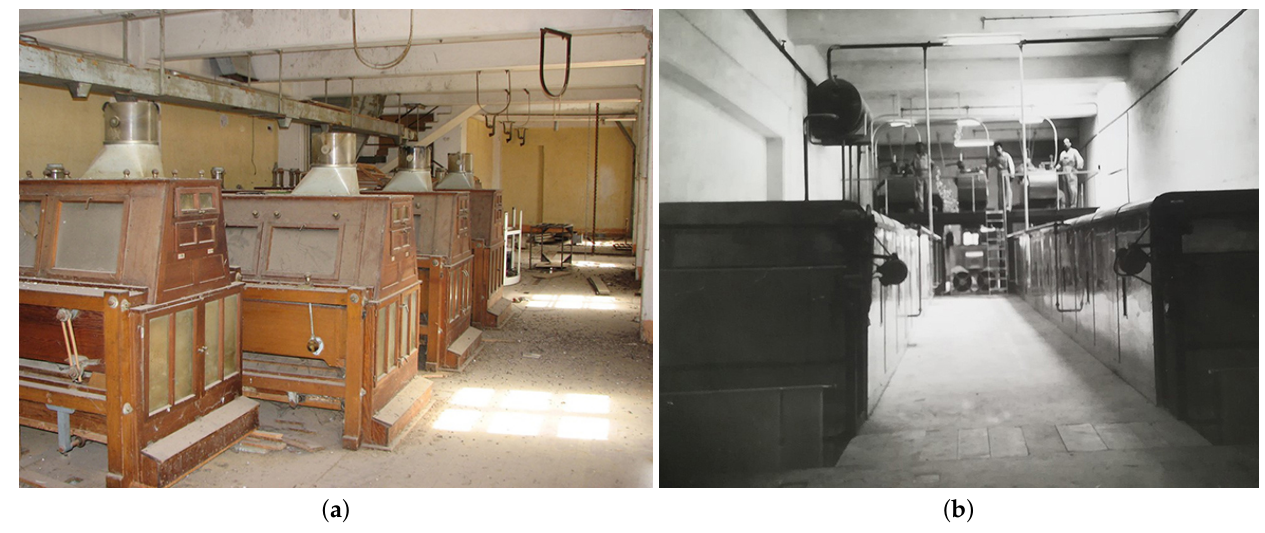
Figure 3. Historical photos of Molino-Pastificio Soresi. ( a ) Semolator machines; ( b ) Machines for the production of short pasta.